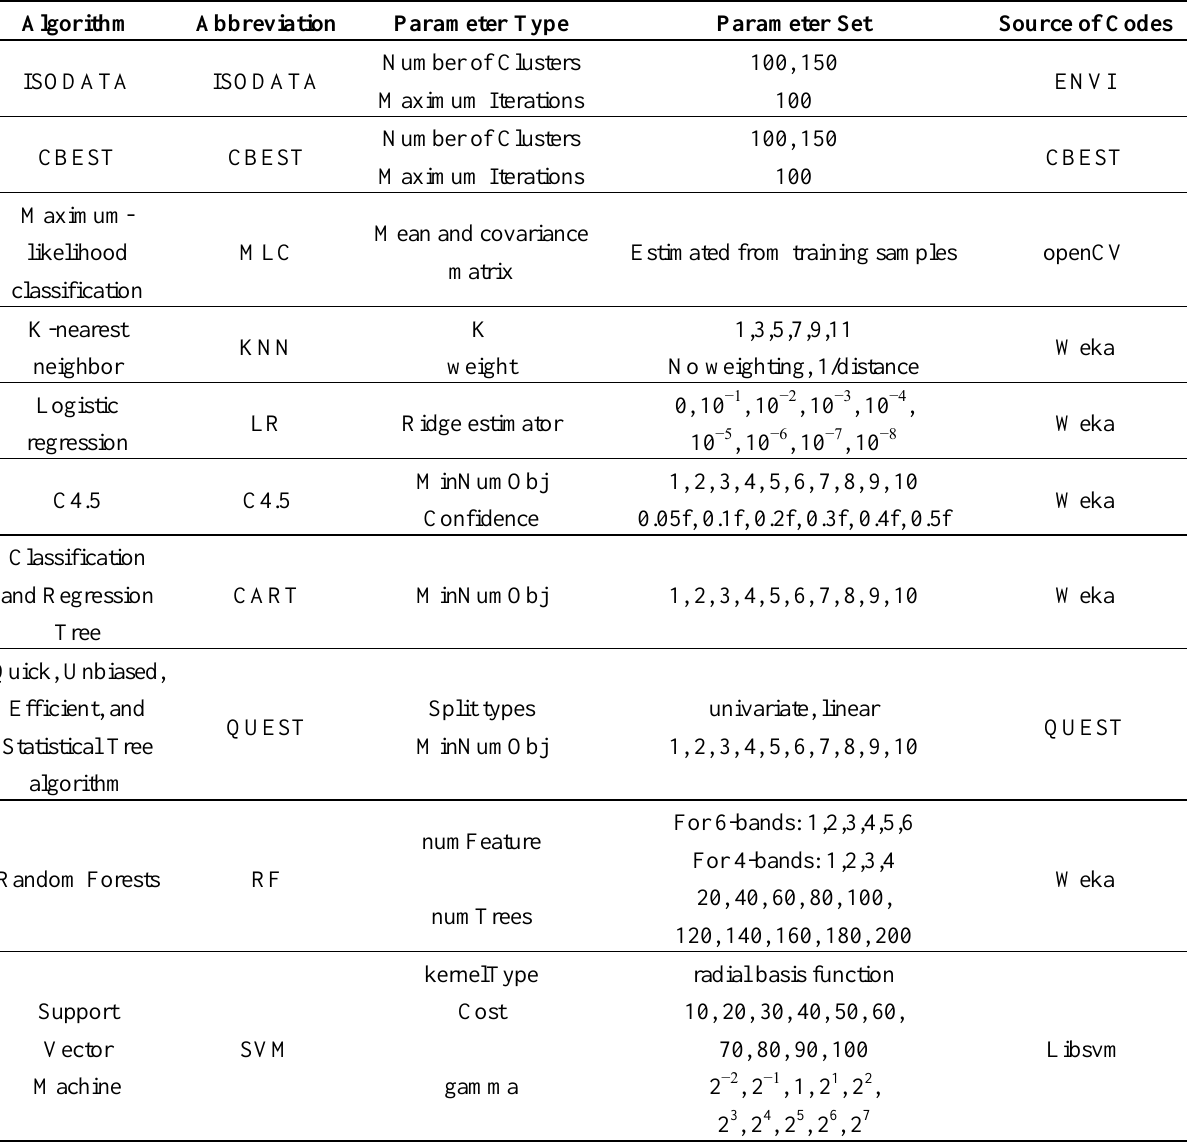
Table 2. Algorithm parameter set up and source of